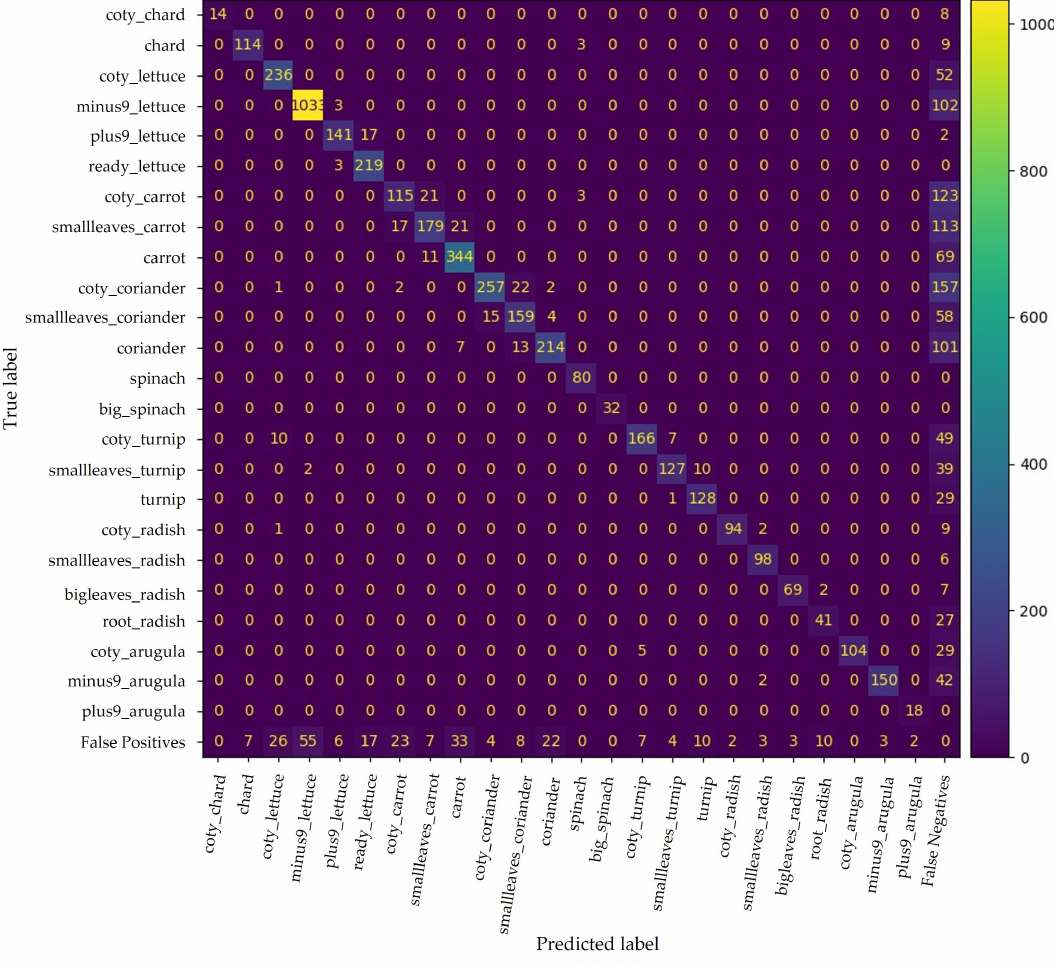
Figure 10. Confusion matrix for YOLO v4 trained with all available data. False positives and false negatives include improperly predicted plants and undetected plants,